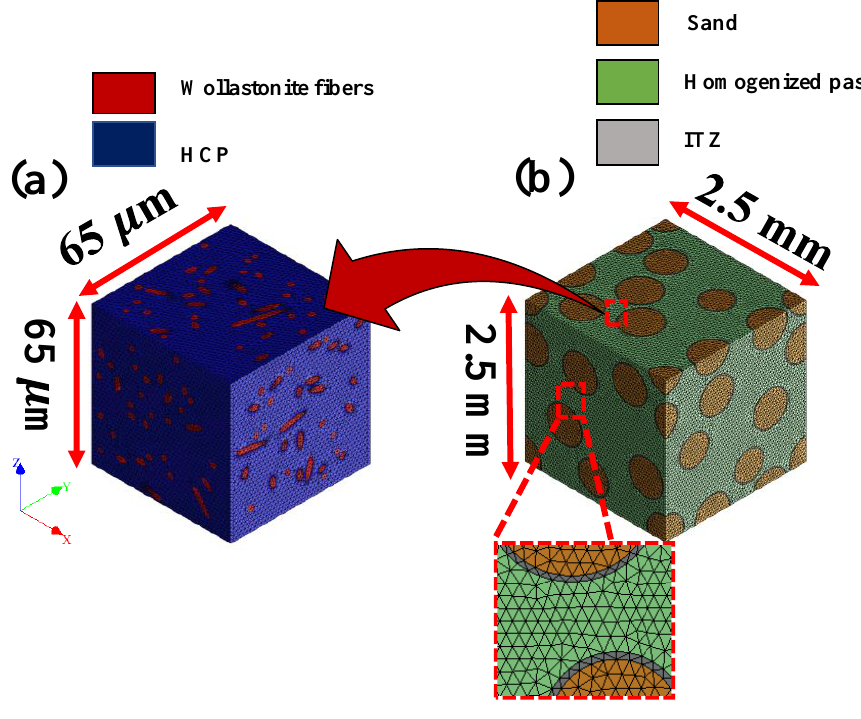
Figure 2. Representative geometry at ( a ) paste scale with 10% wollastonite fibers in HCP matrix and ( b ) mortar scale with sand inclusions in homogenized paste.